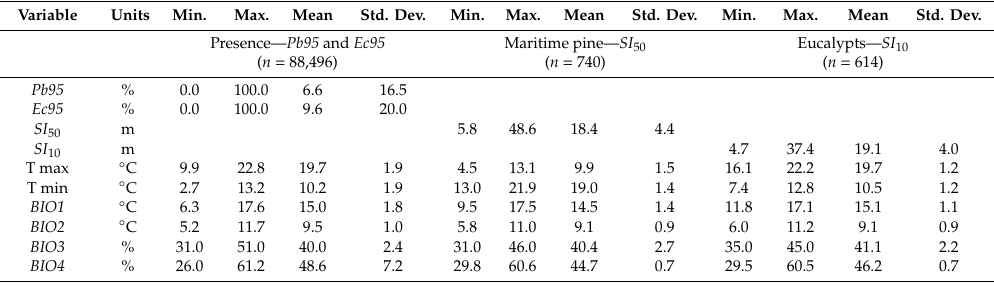
Table A1. Summary statistics: Species presence in COS 1995 (maritime pine— Pb95 ;